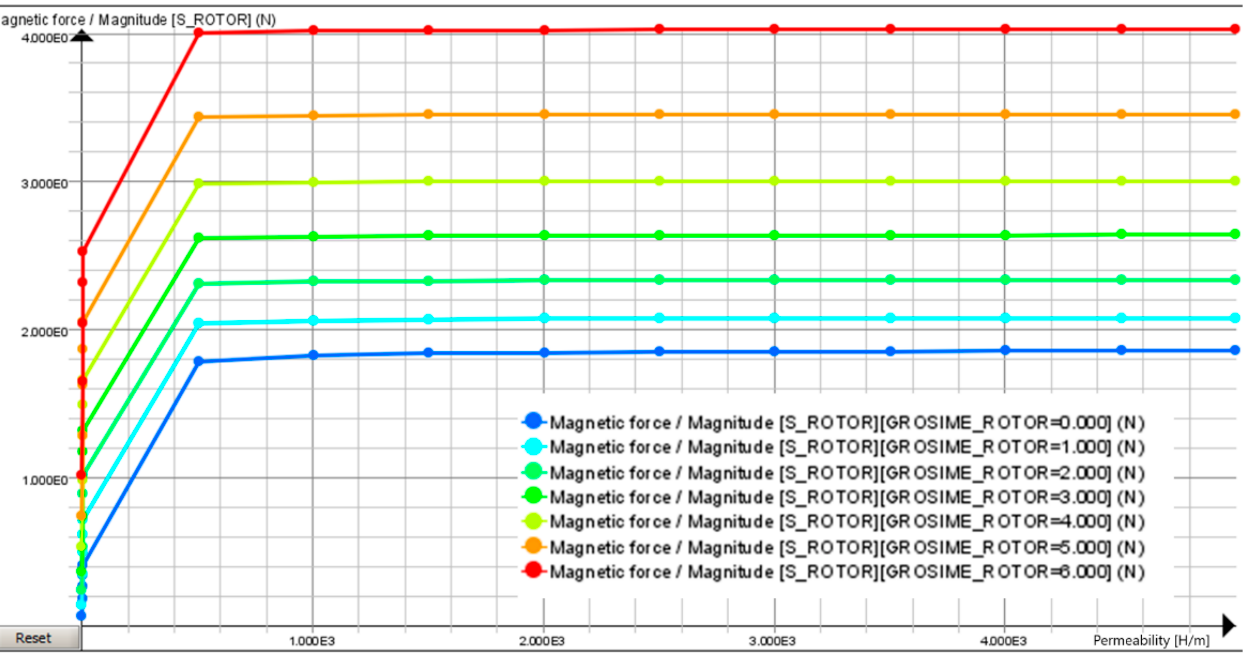
Figure 22. Variation of the magnetic force of attraction to the change in permeability gadolinium and rotor thickness (=GROSIME)—2D representation.